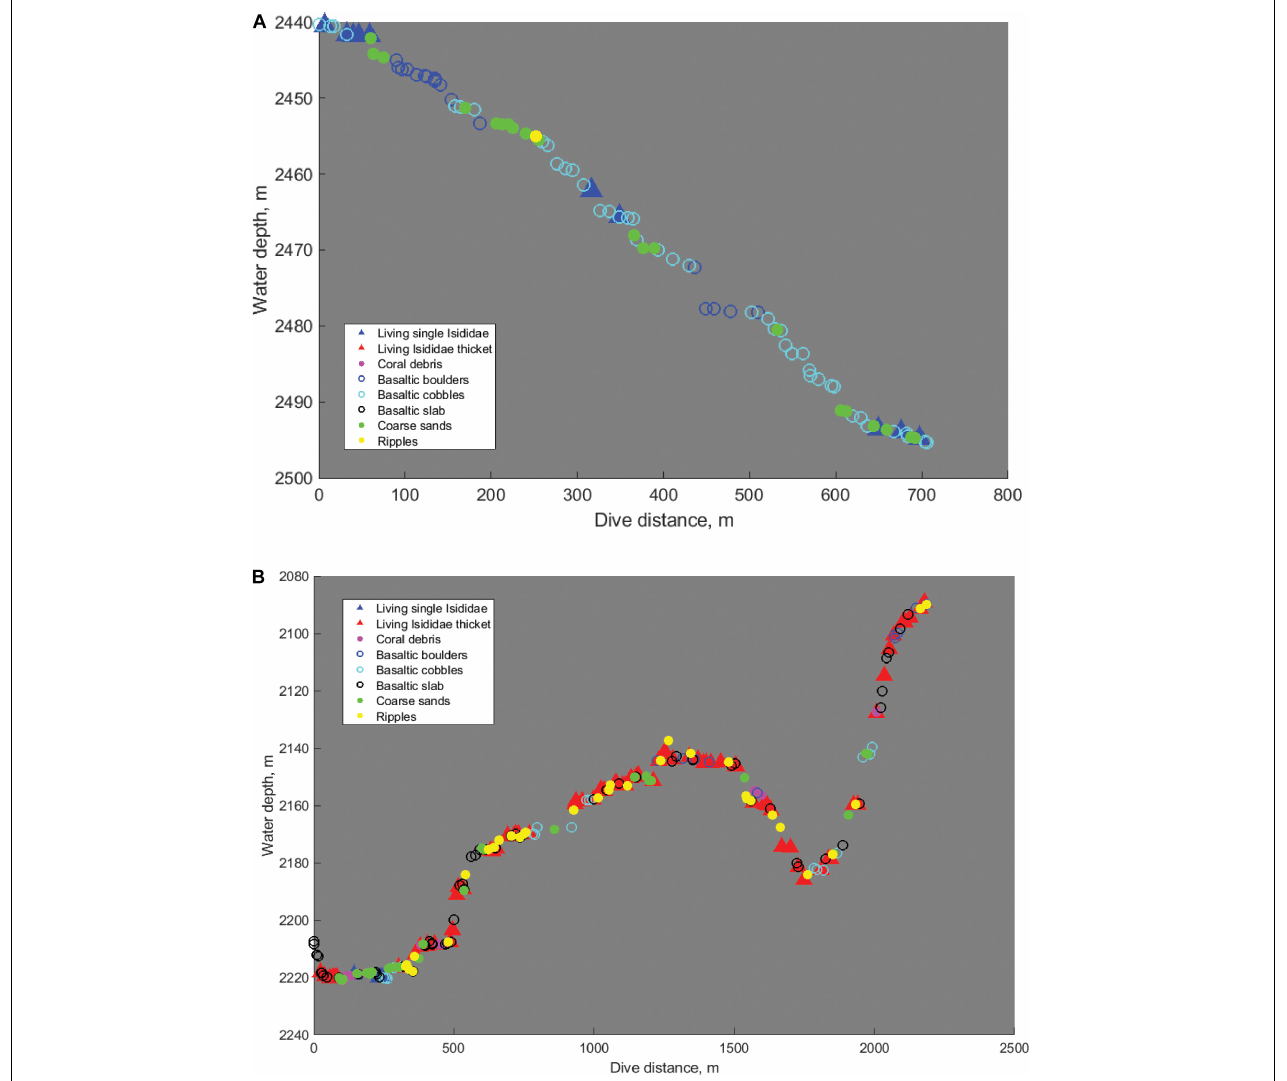
FIGURE 4 | Facies distribution along “Te Tuku” mesa (A) and “Te Kawhiti” ridges summit (B) . Red and blue filled triangles represent the occurrence of single Isididae and Isididae thickets. No Isididae thickets and basaltic slabs were observed along “Te Tuku” dive. Fewer Isididae were observed at depths where coarse sands are dominant. The substrates for the Isididae are ferromanganese-encrusted basaltic boulders, cobbles, and slabs represented in circles. Green, yellow, and magenta dots represent coarse sands, ripples, and coral